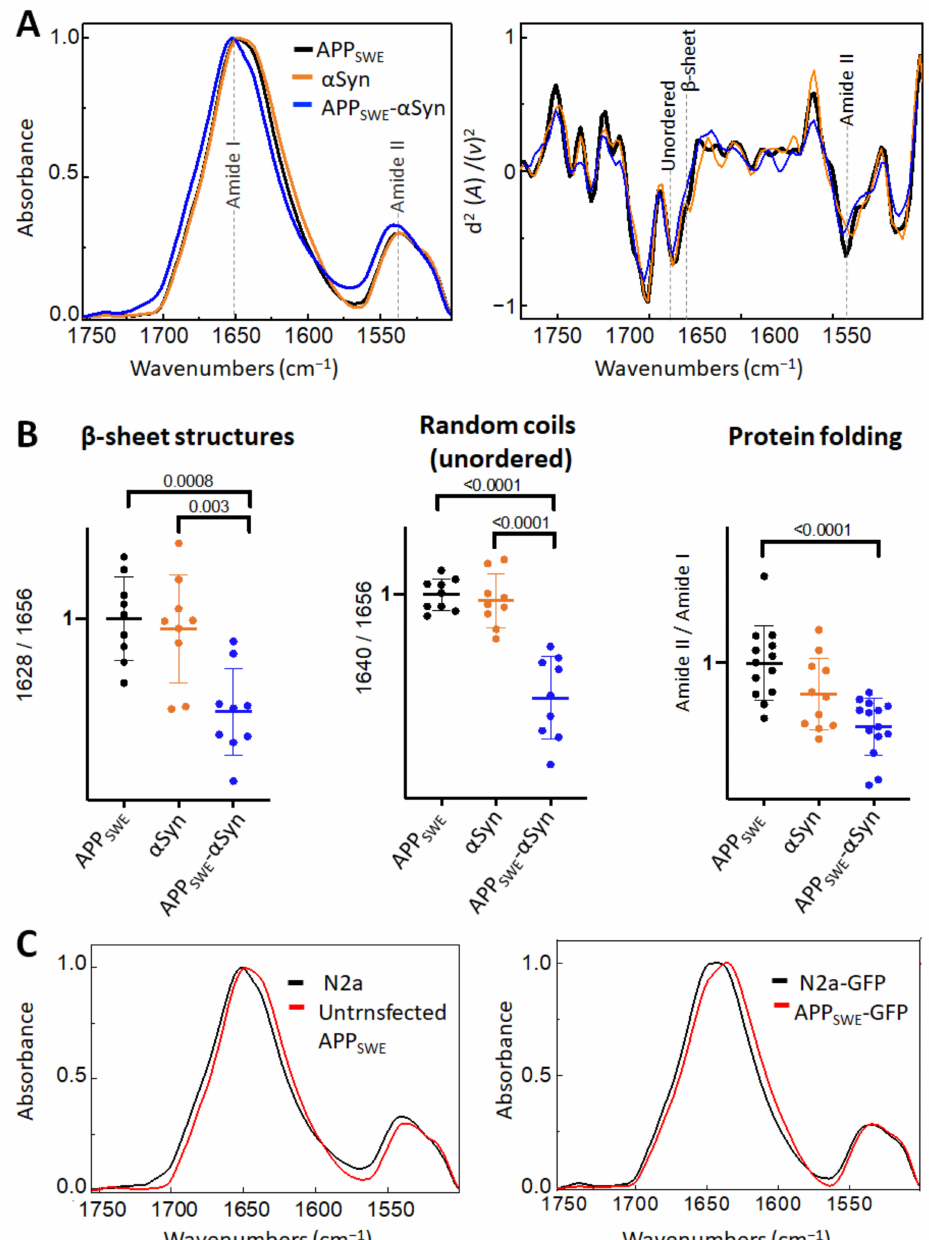
Figure 2. Effect of α Syn (A53T) on A β aggregation in A β / α Syn cellular model of AD. ( A ) Averaged and normalized infrared absorbance spectra and corresponding normalized second derivatives of N2a-APP SWE , N2a- α Syn, N2a-APP SWE - α Syn. Dashed lines indicate peak positions. ( B ) Statistical analysis of structural changes. One-way ANOVA ( p < 0.01) ± s.d; one dot corresponds to a single cell; n = 7–20 cells per independent measurement reproduced at least twice. All values are normalized to the control—N2a-APP SWE cells. ( C ) Averaged and normalized infrared absorbance spectra of N2a-APP SWE and N2a cells untransfected ( left panel ) and transfected with GFP ( right panel